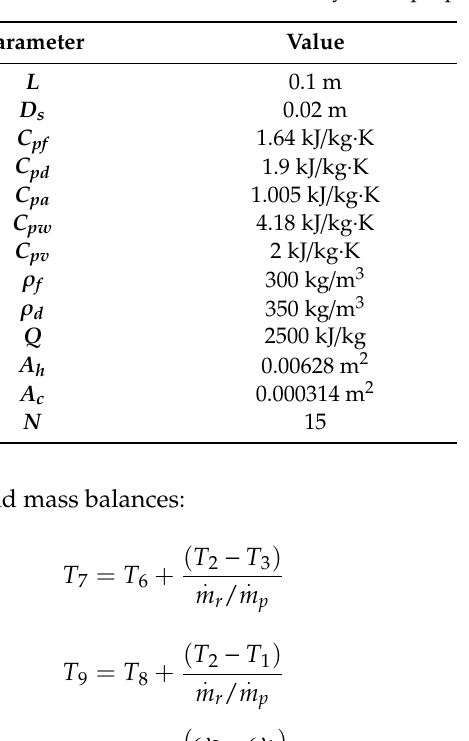
Table 1. Desiccant wheel dimensions and thermodynamic